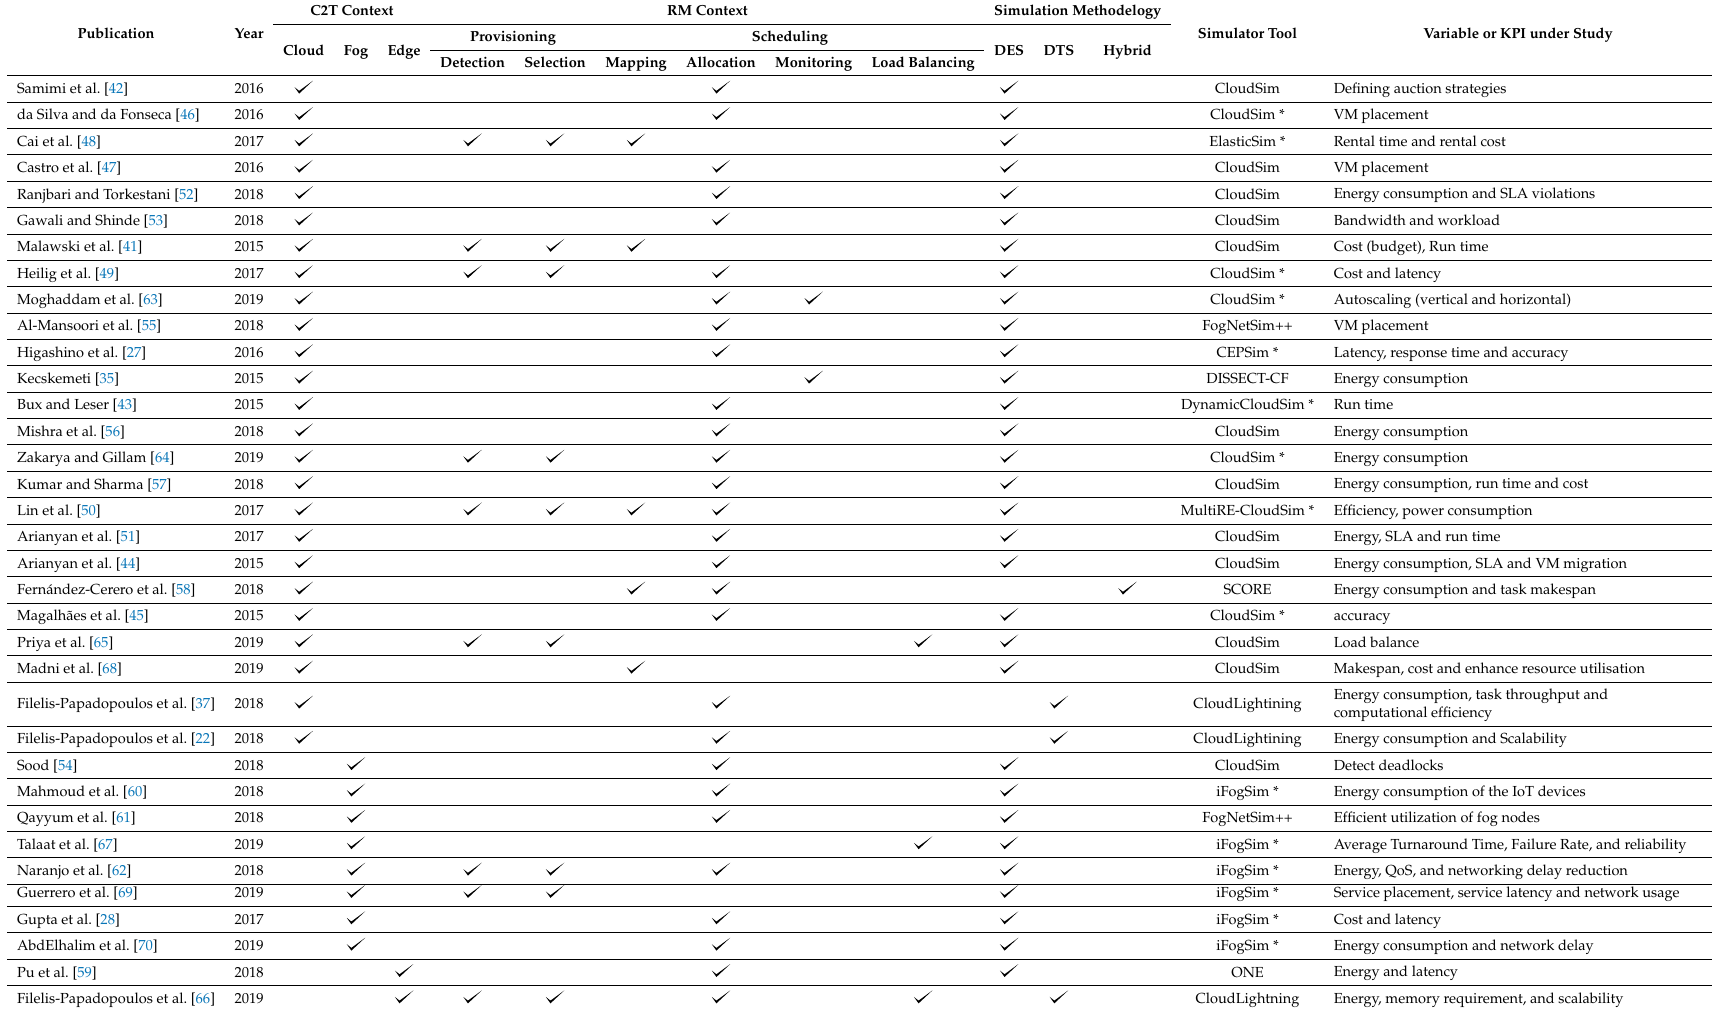
Table 3. Selected articles: Comparative study (* denotes an extension or variant of